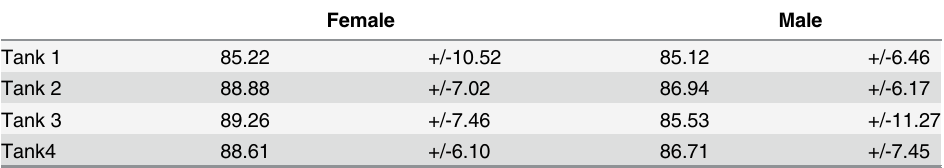
Table 1. The initial lengths (mm) of fish in the four replicates.